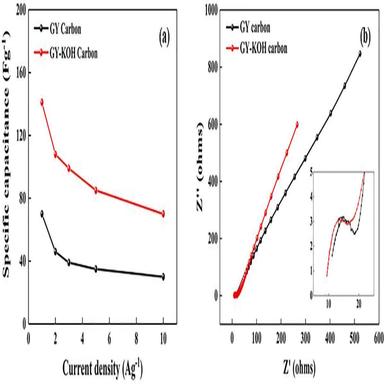
pecific capacitance at different current densities (a), Nyquist plots (b) for non-activated (GY-carbon) and KOH-activated (GY-KOH carbon) carbon materials derived from BNC.